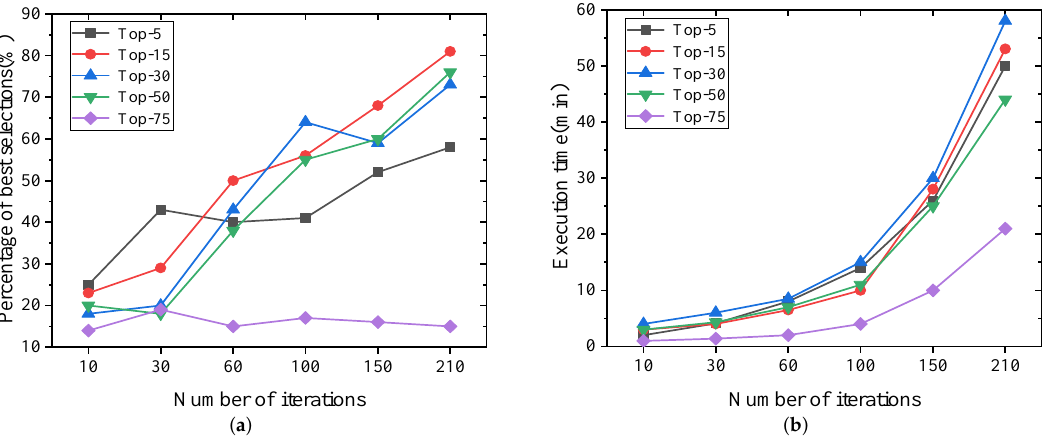
Figure 6. Effectiveness and efficiency of various parameter combinations for GRASP-AR. ( a ) Percentage of Best Selections; ( b ) Execution